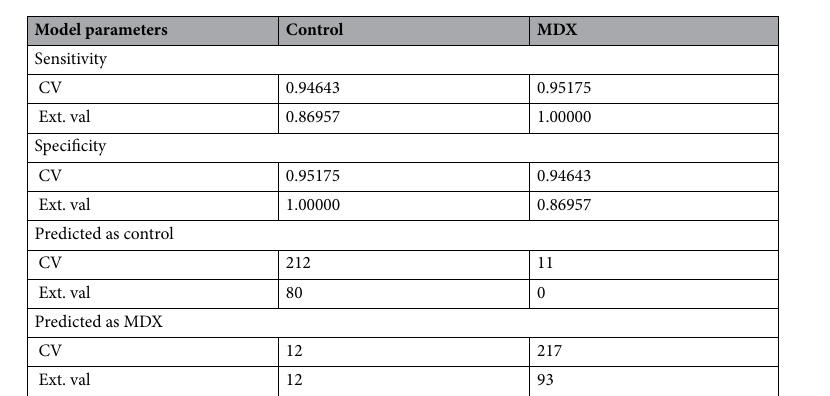
Table 1. Cross-validated (CV) and external validation (ext. val.) PLS-DA prediction results for distinguishing between control and MDX blood serum donors.